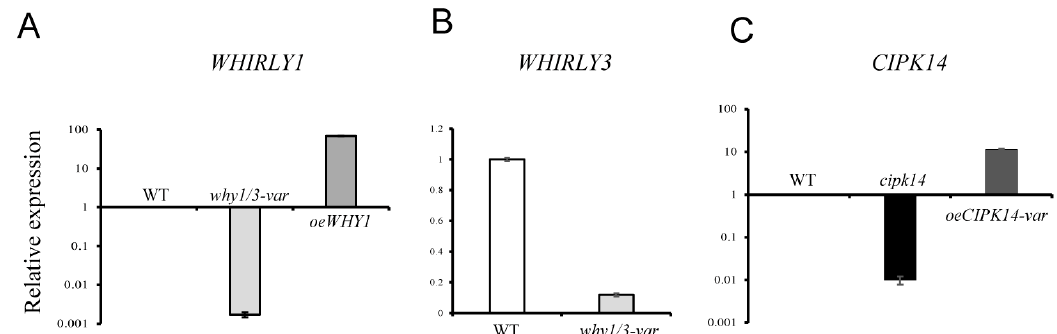
Figure 4. The transcript levels of WHIRLY1 , WHIRLY3 and CIPK14 in the used lines. ( A ) The level of expression of WHIRLY1 in the WT, why1/3-var and oeWHY1 ; ( B ) The level of expression of WHIRLY3 in the WT and why1/3-var ; ( C ) The level of expression of CIPK14 in the WT, cipk14 and oeCIPK14-var . We further analyzed the transcript levels of the encoding genes of differentially expressed proteins. Relative protein abundance of WT and why1/3-var is represented by percent volume on the